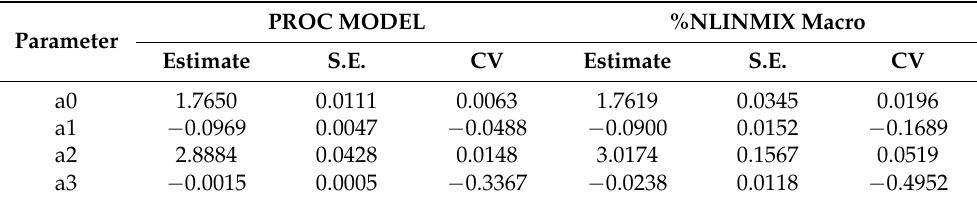
Table 5. The parameter estimates for model 18 using the PROC MODEL and the %NLINMIX